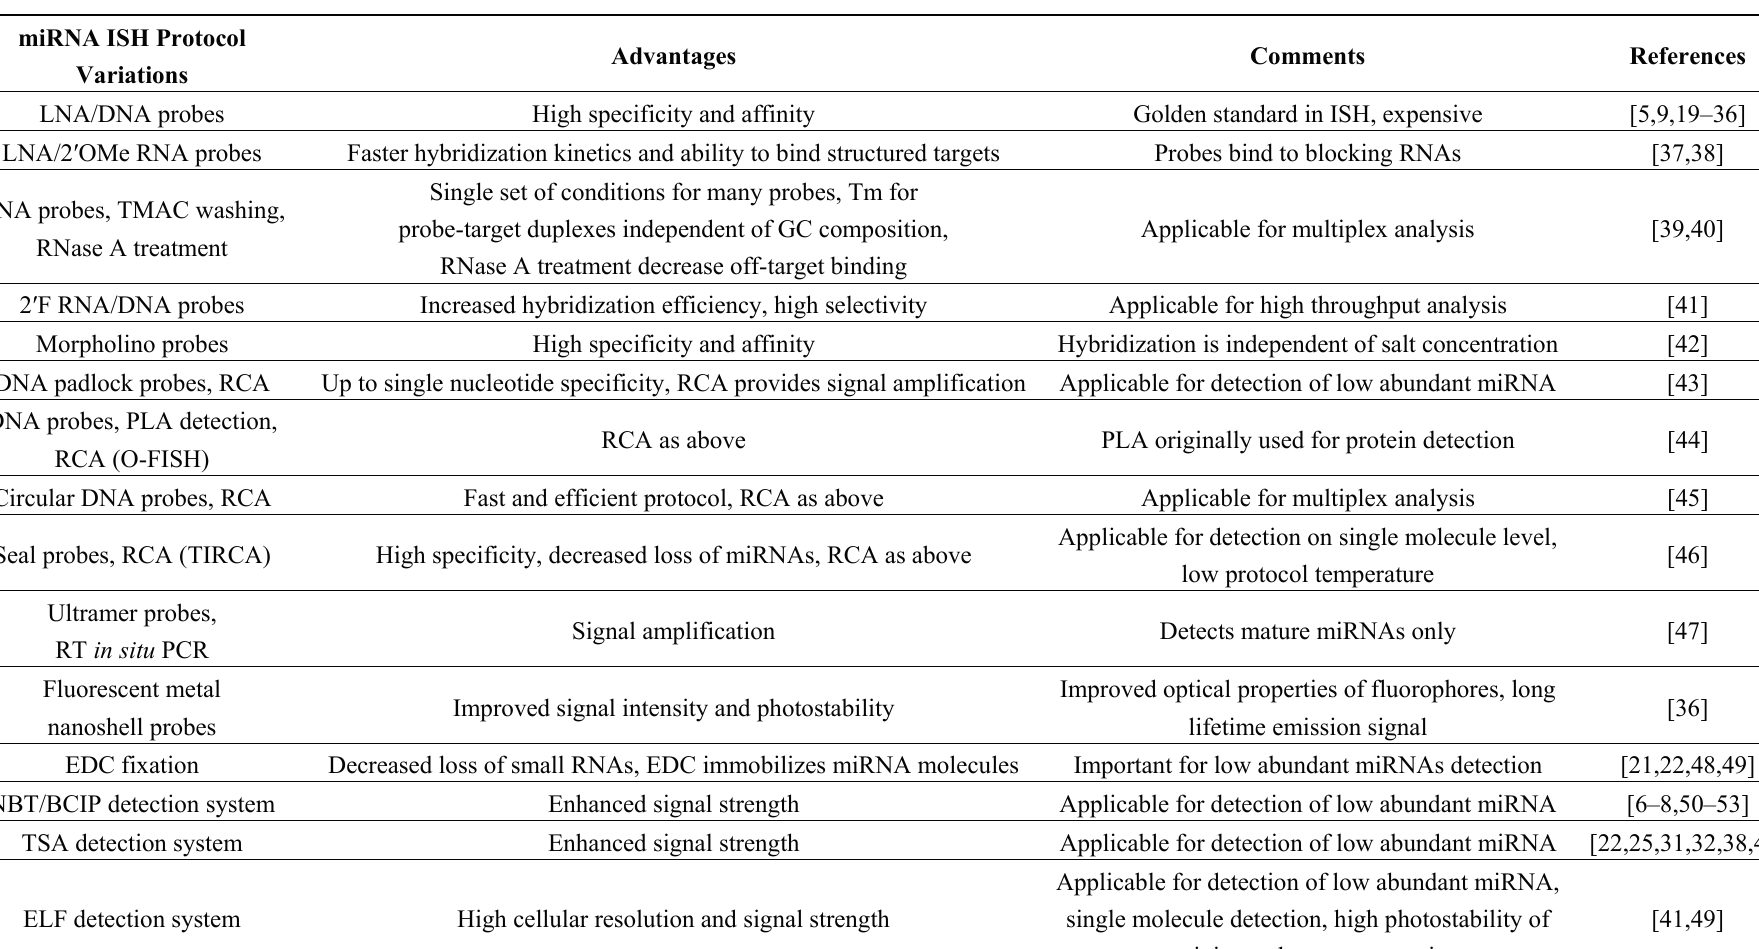
Table 1. Variations in the critical steps of the small RNA in situ hybridization (ISH) protocol. All abbreviations are explained in the